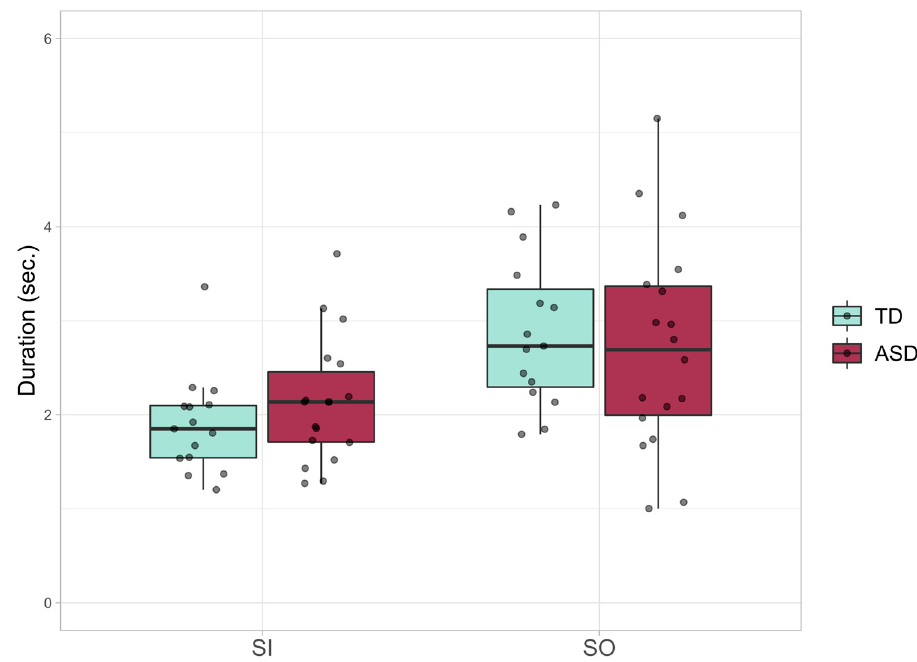
Figure 1. Smile Duration; boxplots of the average duration for Simple (SI) and Social (SO) Smiles in ASD (Autism Spectrum Disorder) and TD (typically developing) groups.